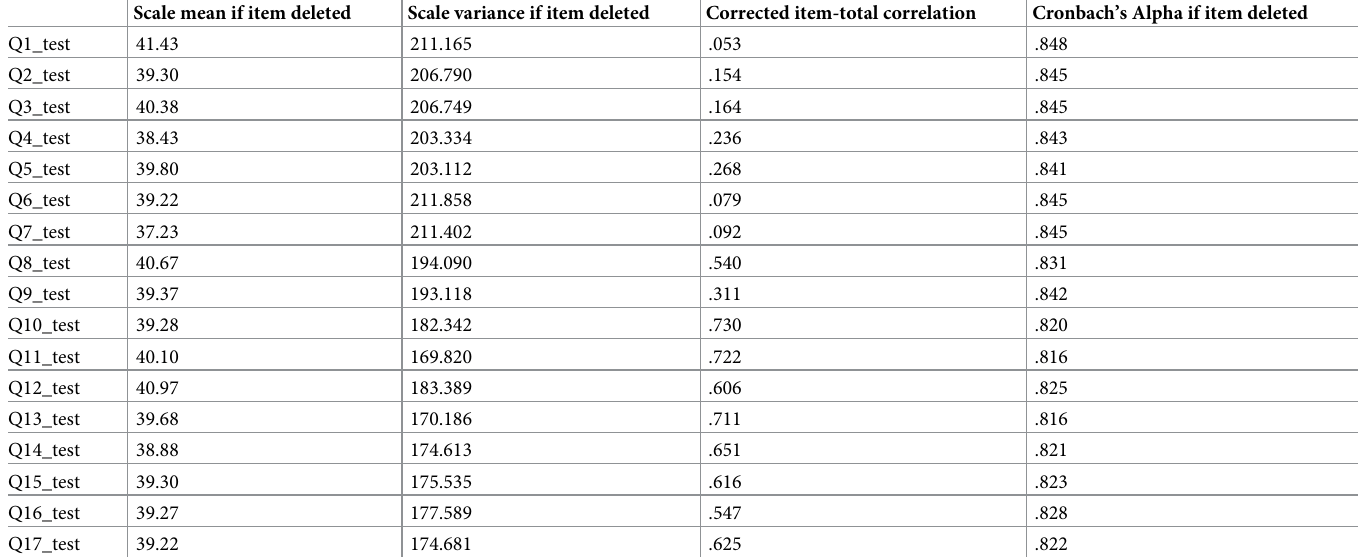
Table 1. Item-total statistics of the Persian (Farsi) QoLAF-Q. Scale mean if item